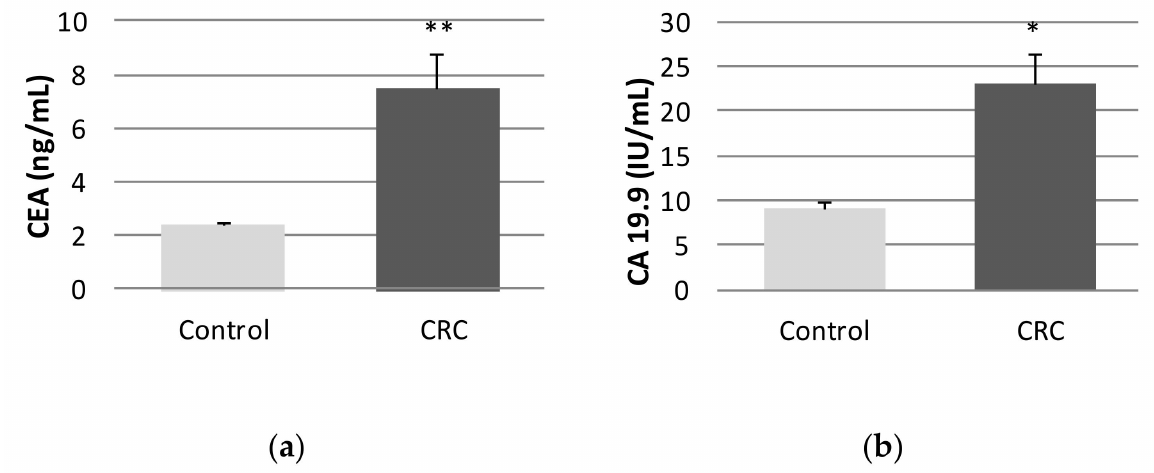
Figure 1. Tumor markers of controls and colorectal cancer (CRC) patients. ( a ) CEA and ( b ) CA 19.9. * p -value adjusted by age and body mass index (* p < 0.05; ** p < 0.01); Data are expressed as the mean ± standard error of the mean. CEA: carcinoembryonic antigen (normal value: <5 ng/mL); CA 19.9: carbohydrate antigen 19.9 (normal value: <37